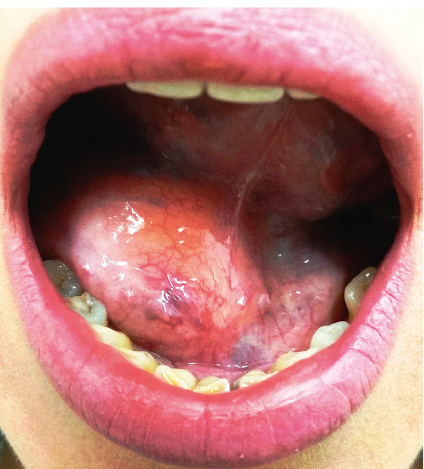
Figure 1: Preoperative image of the mouth reveals a huge soft tissue swelling affecting the right floor of the mouth.